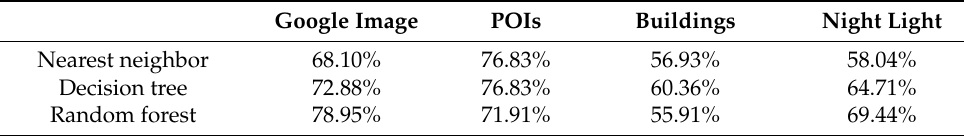
Table 2. PLES layout of